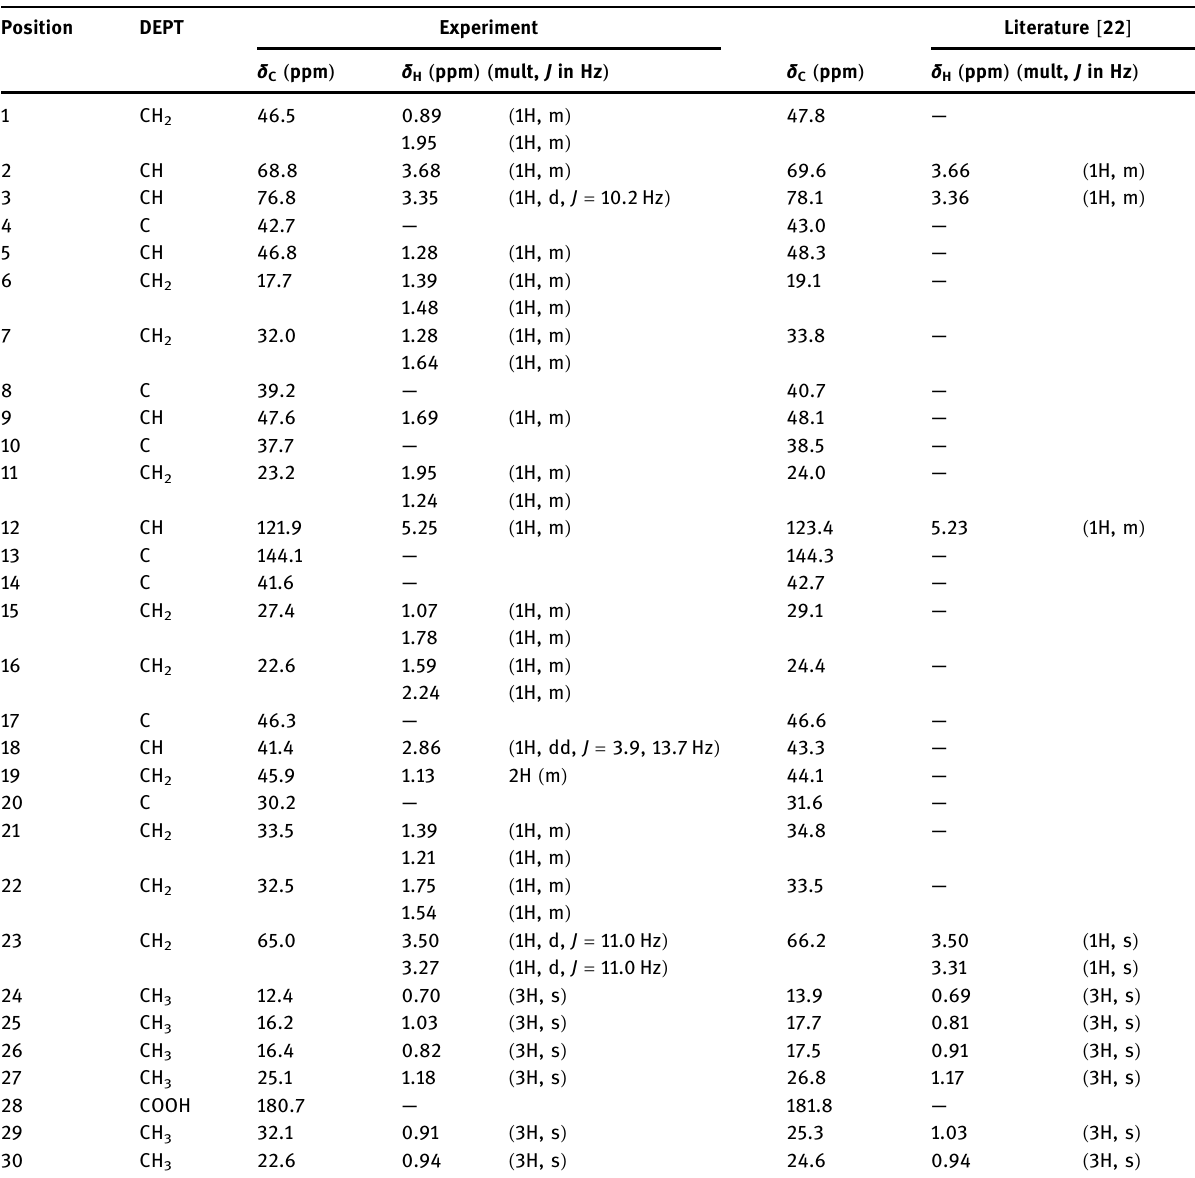
Table 2: NMR spectra of arjunolic acid by comparing to literature Position DEPT